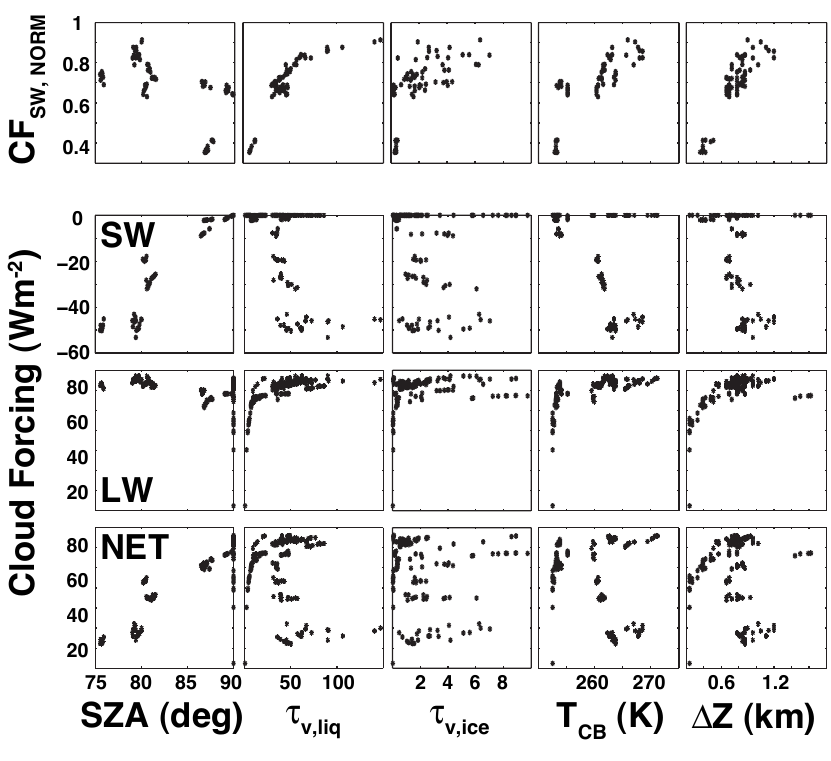
Fig. 7. Shortwave (SW, top), longwave (LW, middle) and net (bottom) cloud radiative forcing as a function of (from left to right) solar zenith angle (SZA), visible liquid optical depth ( τ v,liq ), visible ice optical depth ( τ v,liq ), cloud base temperature (T CB ), and cloud thickness ( ∆ Z) for profiles observed during M-PACE.